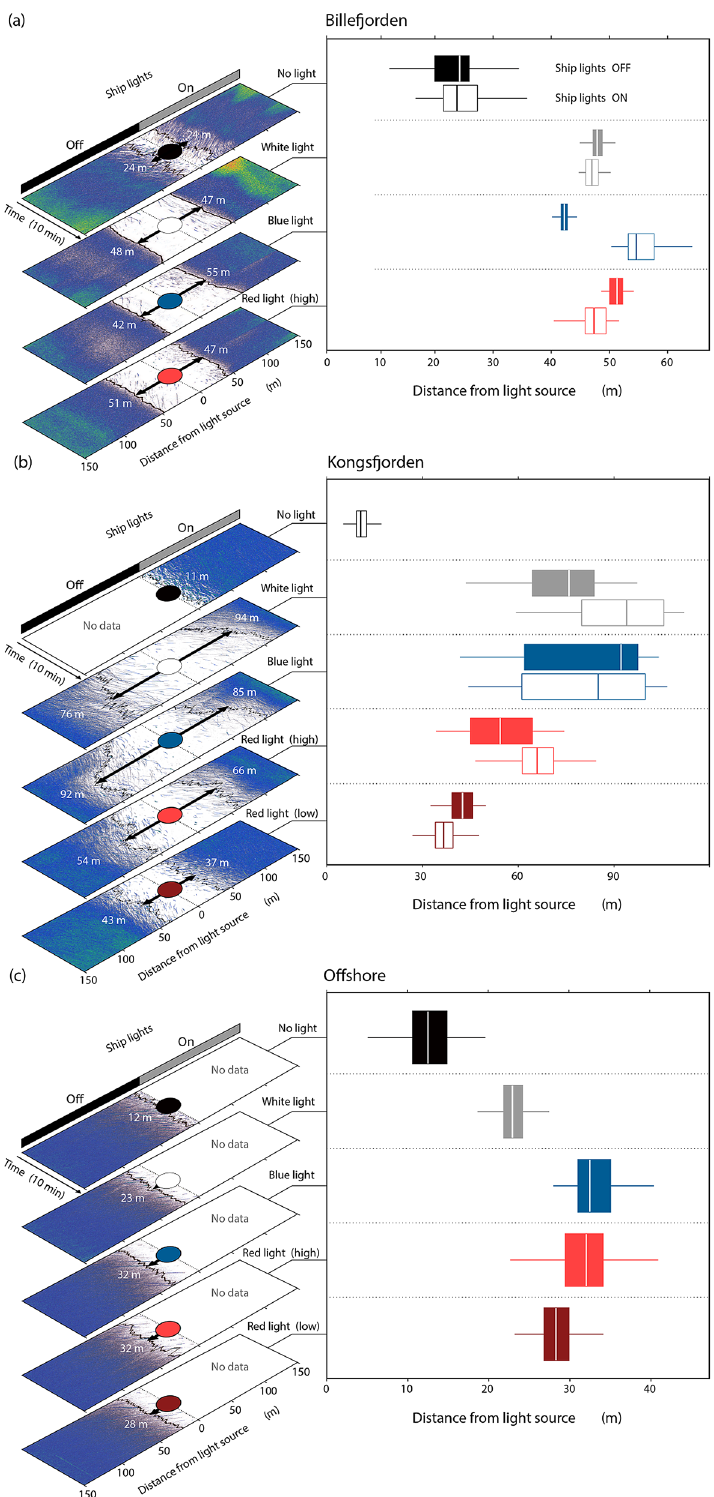
Figure 3. Left panels: Volume backscattering strength echograms (S v ) from the WBAT for 10-min deployments in ( a ) Billefjorden, ( b ) Kongsfjorden, and ( c ) Offshore Svalbard under different light filters and with the ship’s lights turned on or off. The black line indicates the range from the transducer to the − 90 dB (Billefjorden), − 95 dB (Kongsfjorden) or − 110 dB (offshore) backscatter threshold and the arrow indicates the median range (i.e., median avoidance distance). Right panels: Corresponding box plots of the avoidance distance. Range boxes show the 25th, 50th, and 75th and whiskers the 5th and 95th percentile, outliers are